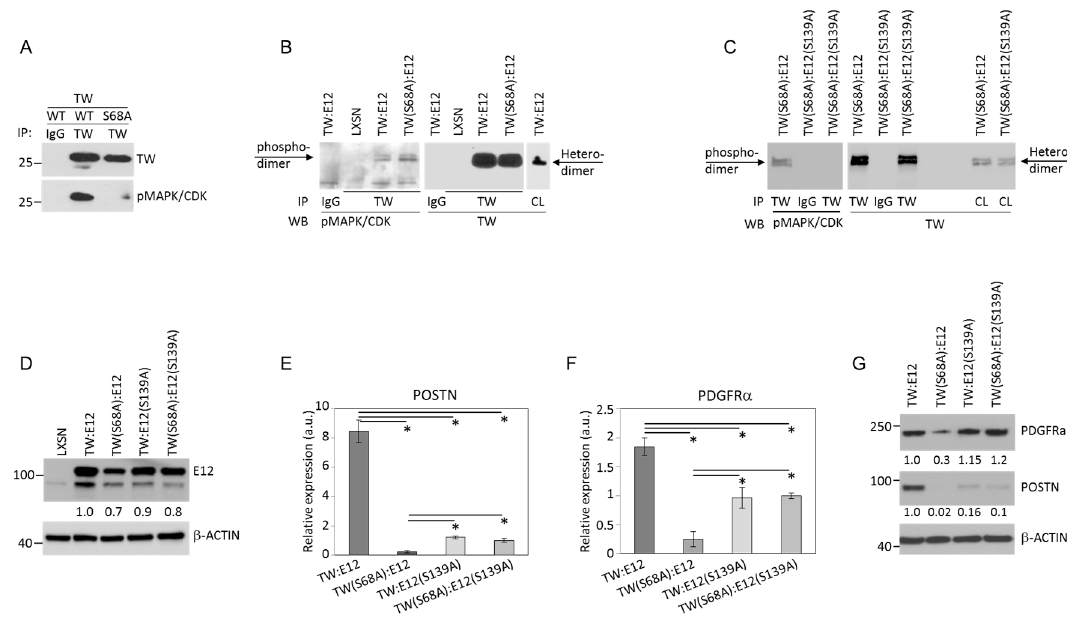
Figure 5. E12 phosphorylation is necessary for regulation of POSTN mRNA expression by TW. ( A ). Confirmation of specificity of pMAPK/CDK substrate antibody. T98G cells with overexpression WT TW or TW(S68A) mutant were immunoprecipitated with TW antibody or nonspecific